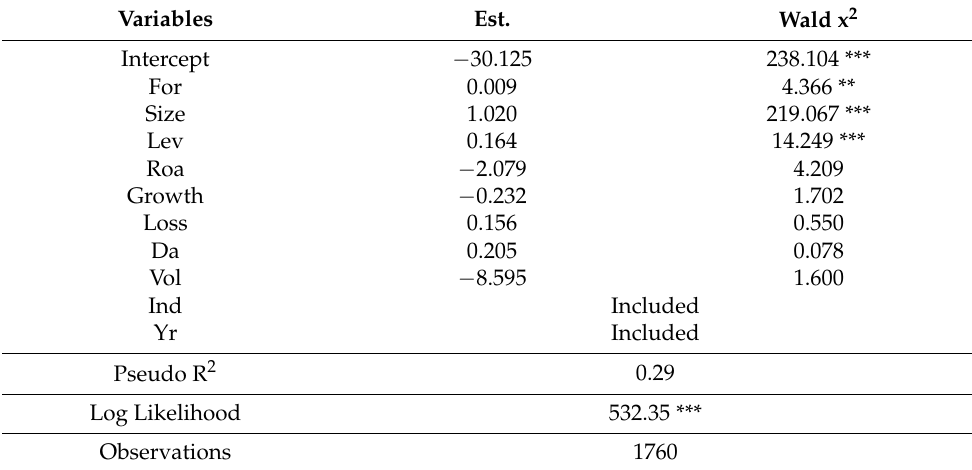
Table 5. The relationship between foreign investors and voluntary